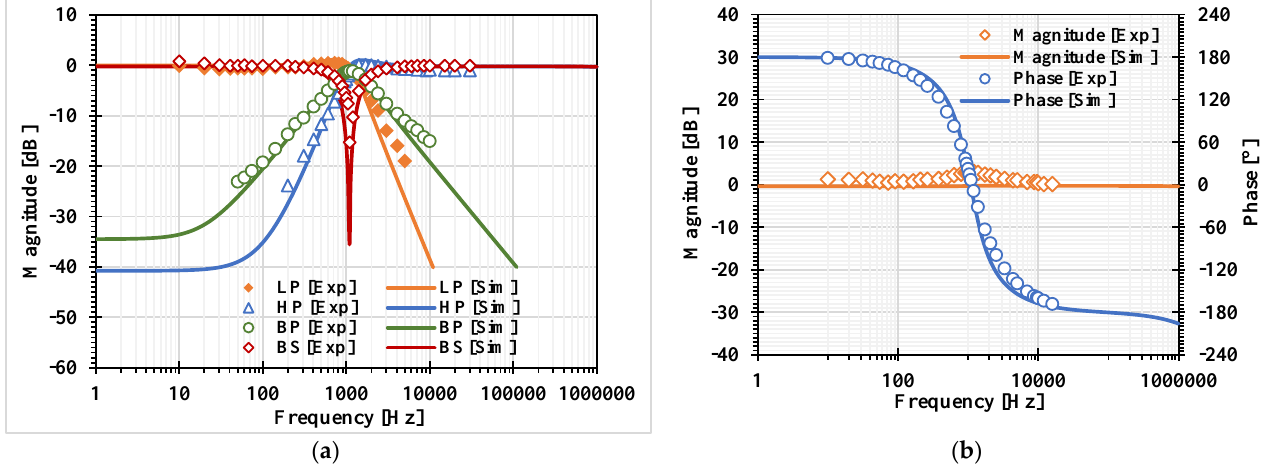
Figure 18. Experimental frequency responses of the CM filter: ( a ) LP, BP, HP, BS filters; ( b ) AP fil- ter.